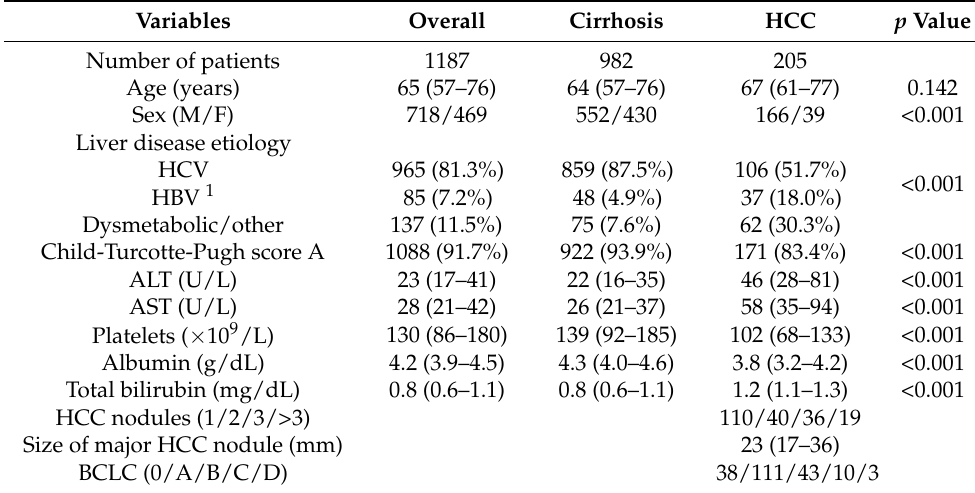
Table 1. Demographic, clinical, and biochemical characteristics of the patients enrolled in the study.